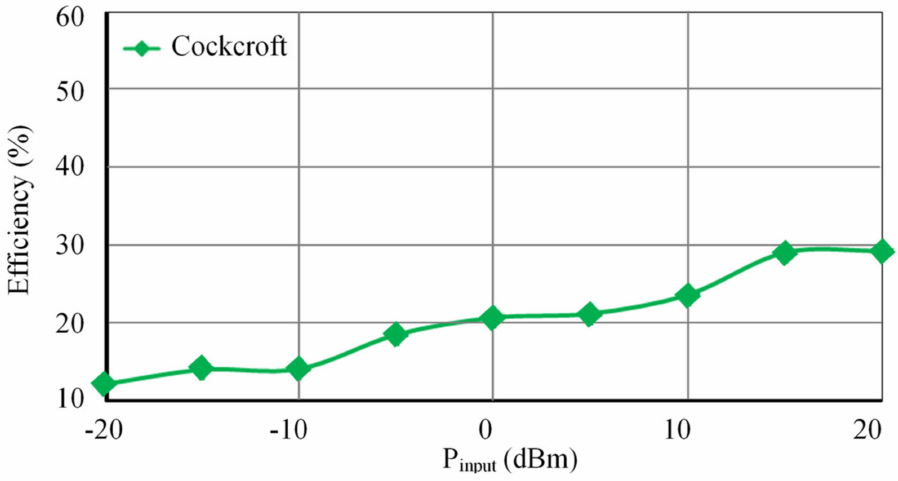
Figure 21. Efficiency curve of Cockcroft-Walton voltage